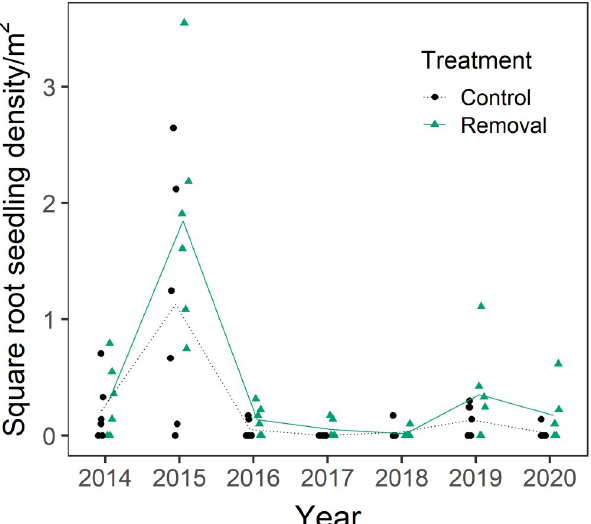
Fig 2. Seedling densities as measured in June of each year, for control (black circles) and non-native removal (green triangles) treatments. The lines represent annual mean values for control (black dotted) and removal (green solid). Seedling densities are shown on a square-root- transformed scale to reduce the distortion by outliers, but our statistical analysis used non-parametric permutation tests on the untransformed data. Control and non-native removal plots were sampled on equivalent dates each year; the series are offset to facilitate visual comparison.